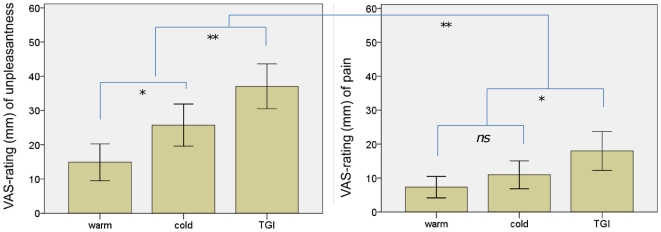
Ratings of the TGI, collected prior to fMRI.Affective-motivational (“unpleasantness”) and sensory-discriminatory (“pain-intensity”) dimensions were rated on separate 100 mm-long VAS scales. Significance levels: ** = p<0.01,* = p<0.05, ns = non-significant.